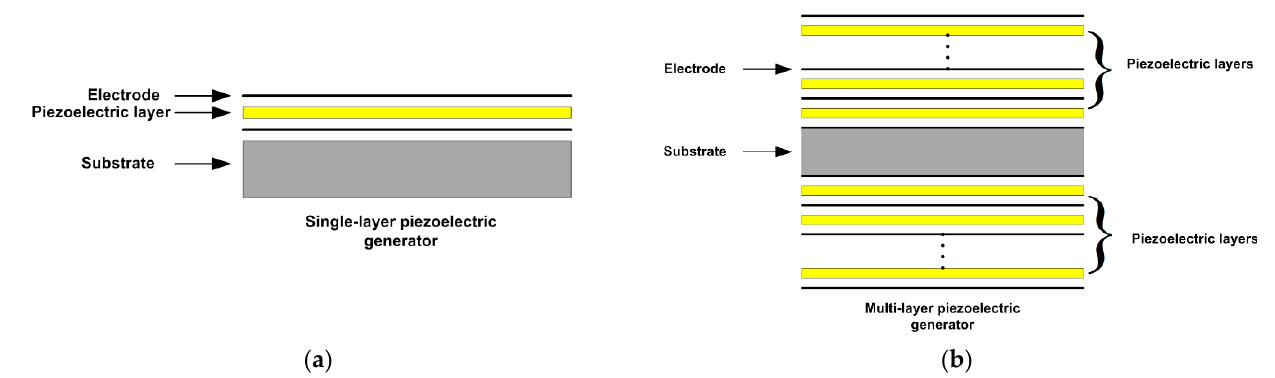
Figure 3. Schematic representation of single-layer ( a ) and multi-layers piezoelectric generators ( b ). Table 1. Comparison between single-layer and multi-layer piezoelectric generators. Single-Layer Piezoelectric Generator